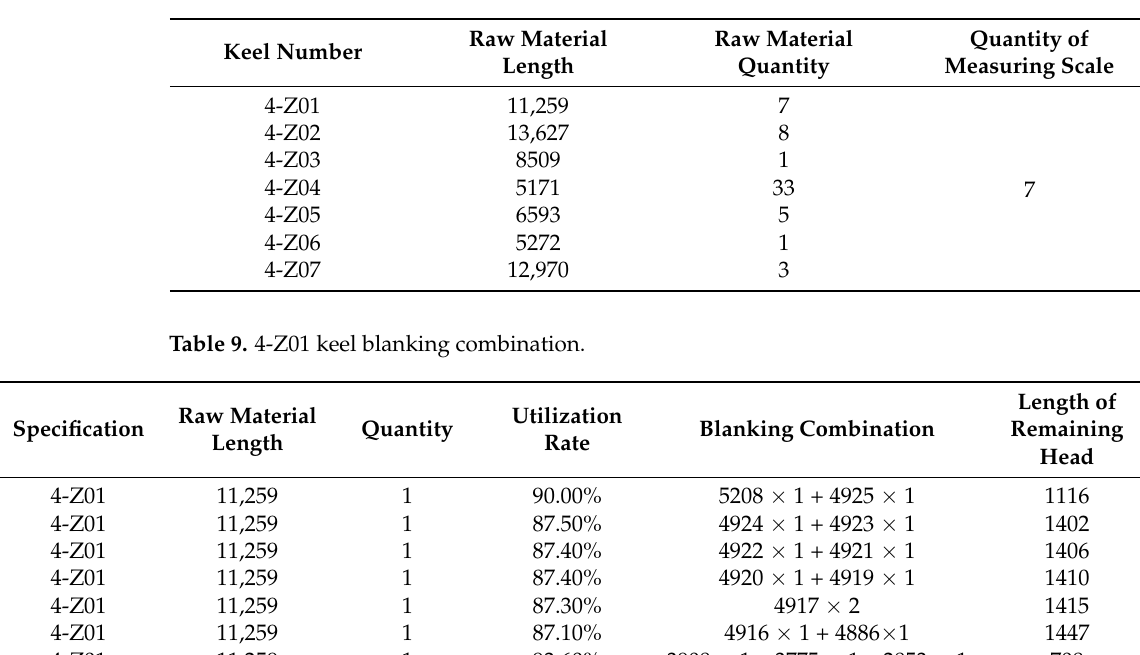
Table 8. Raw material length of the four-span and one-break main curved keel.